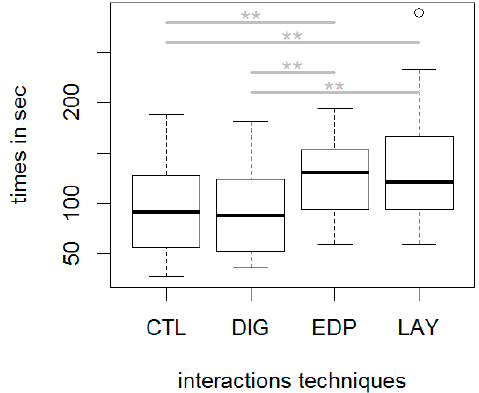
Figure 11. Duration of the relative orientation task with mental rotation per interaction technique. DIG and CTL were quicker than LAY and EDP to estimate direction relationships between elements when performing a mental rotation task. (** p < 0.01).